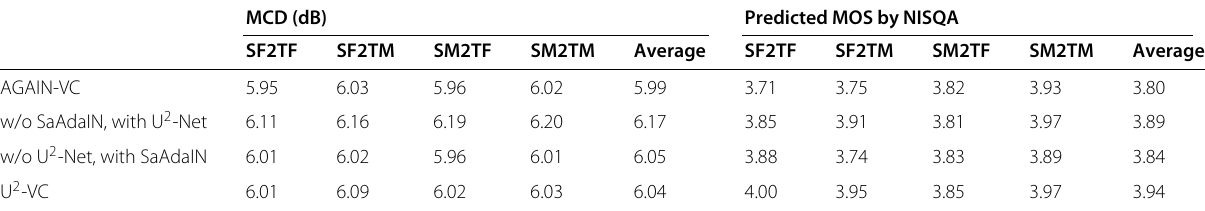
Table 3 Objective evaluation results of the ablation study on architecture in unseen-to-unseen conversion scenario. “AGAIN-VC” represents the network has neither U 2 -Net structure nor SaAdaIN. “U 2 -VC” represents the network has both U 2 -Net structure and SaAdaIN MCD